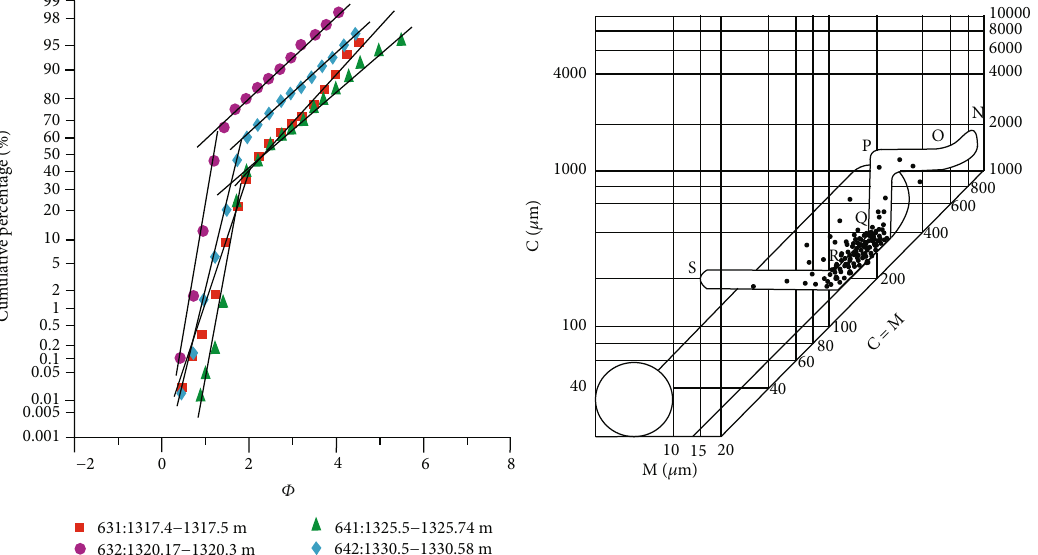
Figure 4: Grain size probability curve and C-M diagram.